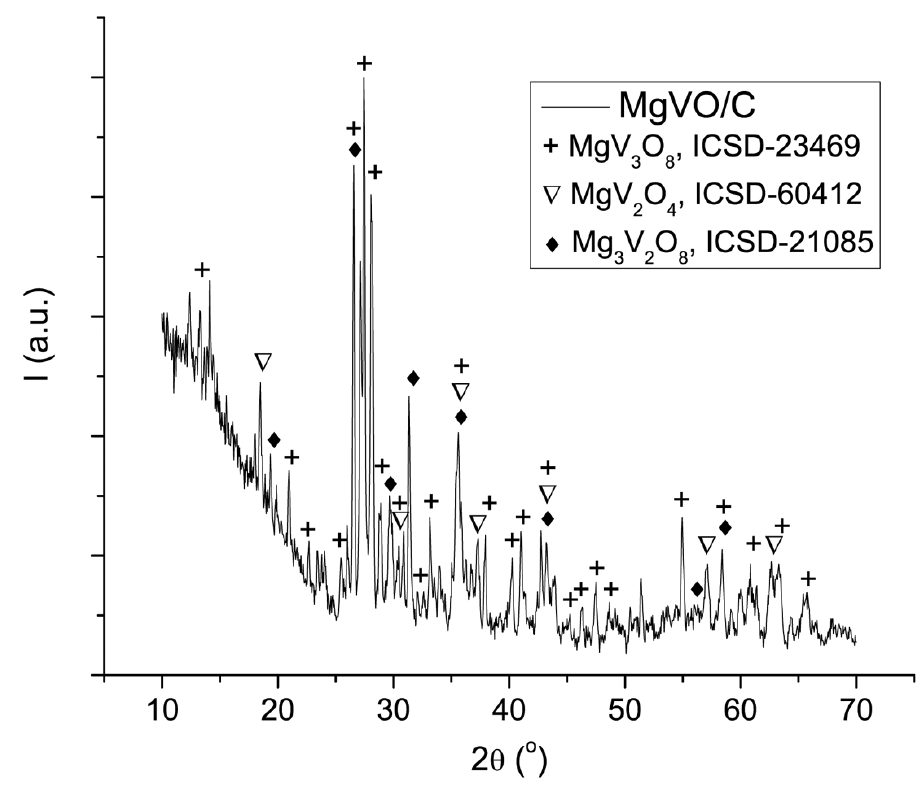
Figure 7. XRD patterns of the MgVO/C material.